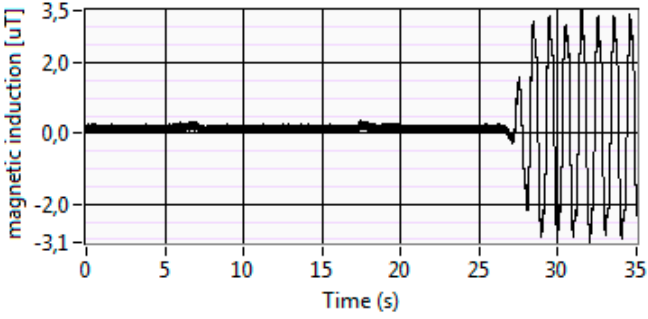
Figure 13. The time waveform representing the MF induction recorded near the cable supplying the bow thruster motor. The sampling frequency is equal to 2000 Hz.